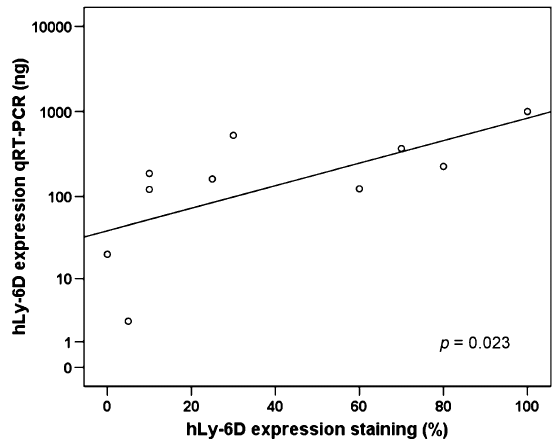
Fig. 1. E48 immunohistochemical staining and hLy-6D qRT-PCR of tumors. To determine the correlation between E48 immune peroxi- dase staining and hLy-6D qRT-PCR we performed hLy-6D qRT-PCR on ten selected frozen tumor specimens: four with high hLy-6D ex- pression ( > 50%) in paraffin embedded biopsies of the tumor, four with intermediate expression (6–50%) and two with low expression ( (cid:3) 5%). On the x -axis the percentage of hLy-6D expression deter- mined by immunostaining is shown and on the y -axis the hLy-6D qRT-PCR value in nanogram determined by hLy-6D